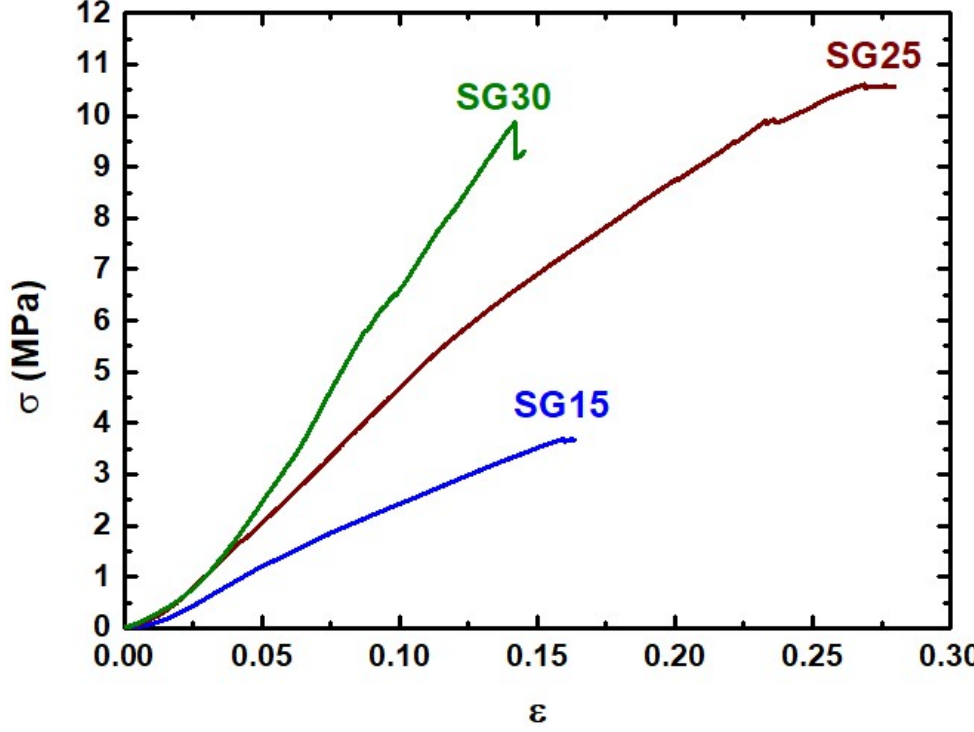
Figure 5. Stress–strain curves of the SG15, SG25, and SG30 aerogels obtained using uniaxial compression tests.